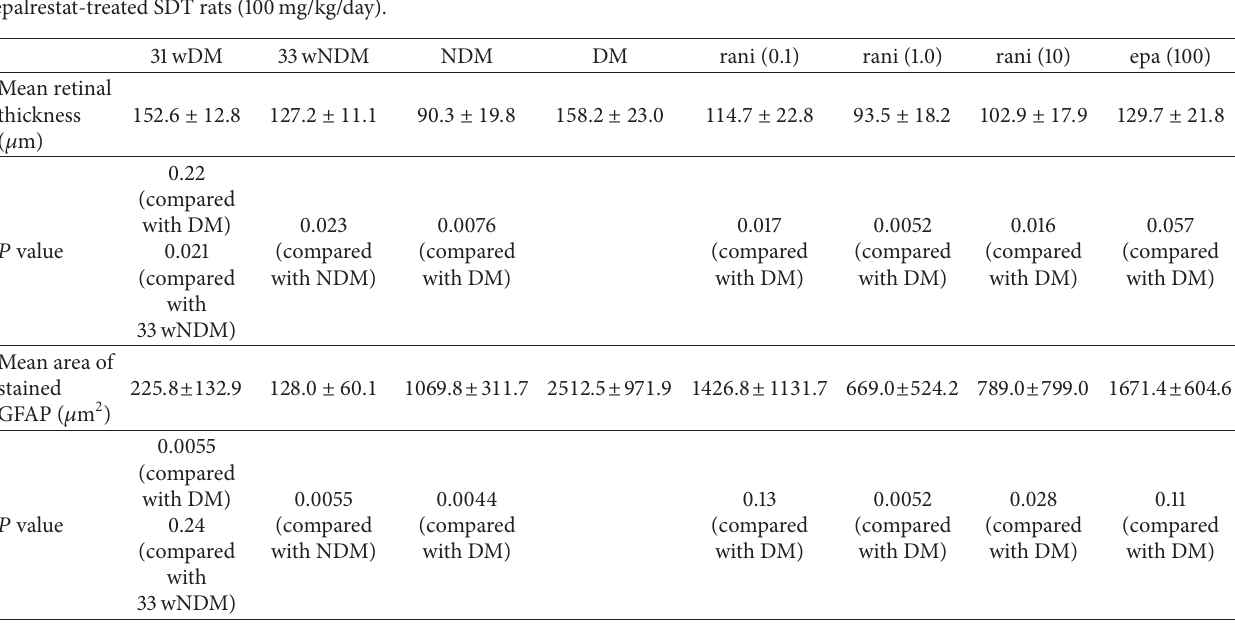
Table 1: The mean retinal thickness and mean area of stained GFAP in each group. 31wDM: 31-week-old SDT rats; 33 wNDM: 33-week-old normal SD rats; NDM: normal SD rats older than 50 weeks; DM: untreated SD rats older than 50 weeks; rani (0.1): ranirestat-treated SDT rats (0.1mg/kg/day); rani (1.0): ranirestat-treated SDT rats (1.0mg/kg/day); rani (10): ranirestat-treated SDT rats (10mg/kg/day); epa (100):